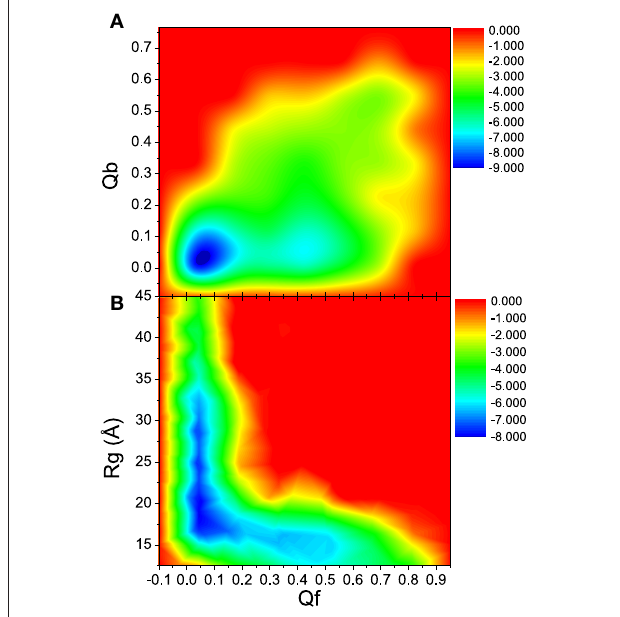
FIGURE 9 | Unfolding landscape with respect to Qb, Rg, and Qf of bound DNA/RNA hybrid. (A) : Landscape of Qb and Qf. (B) : Landscape of Rg and Qf.